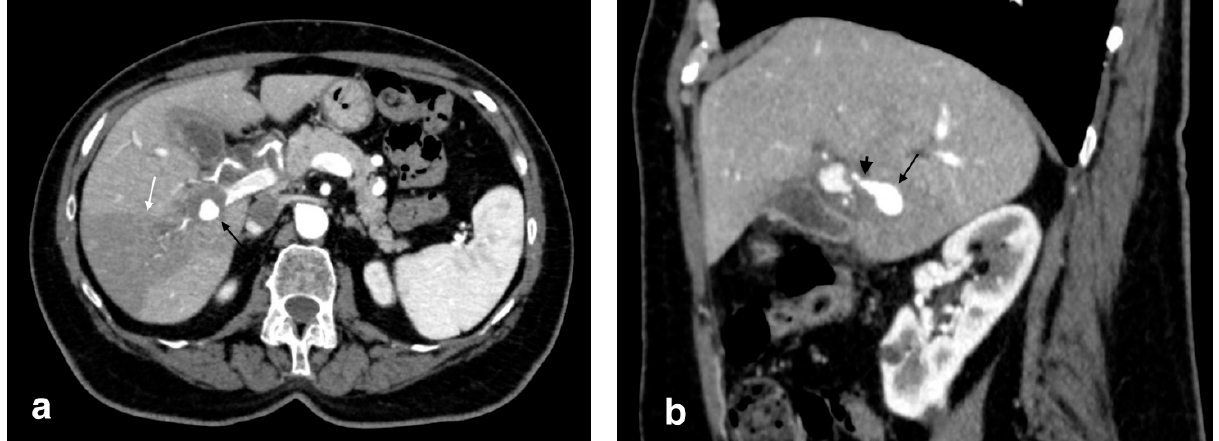
Figure 12. Right hepatic artery pseudoaneurysm: ( a ) axial image in the arterial phase shows an abnormal dilation of the right hepatic artery (black arrow); wedge-shaped area of parenchymal hypodensity (white arrow) secondary to hypoperfusion; ( b ) sagittal image better demonstrates continuity of the abnormal dilation (arrow) with a right hepatic artery branch (arrowhead).